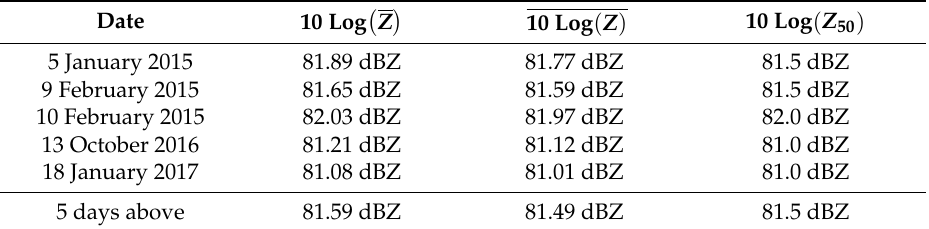
Table 2. Values of three central location parameters for the horizontal reflectivity distribution.